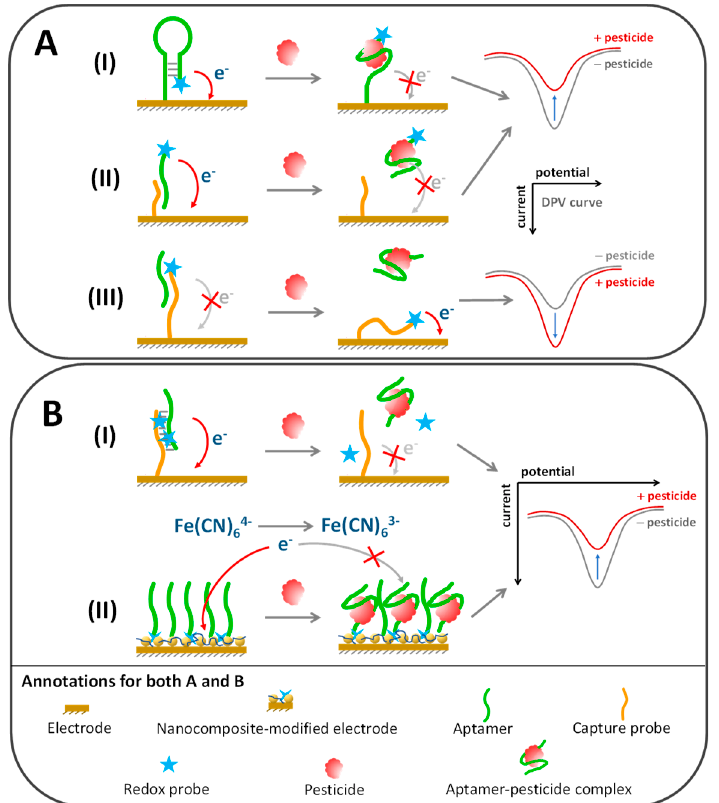
Figure 6. Schematic representation of redox probe-based pesticide detection. ( A ) Labeling strategies in electrochemical pesticide aptasensors: redox probe-labeled hairpin-structure aptamer (I), redox probe labelled-aptamer bystander on capture sequence (II) and aptamer bystander on redox probe-labeled capture sequence (III). ( B ) Noncovalent incorporation of redox probe in electrochemical pesticide aptasensors: intercalation (I) and in situ incorporation of probe with sensing interface (II). (Adapted by permission from Springer Nature Customer Service Centre GmbH: Springer Nature [140], copyright 2020.).